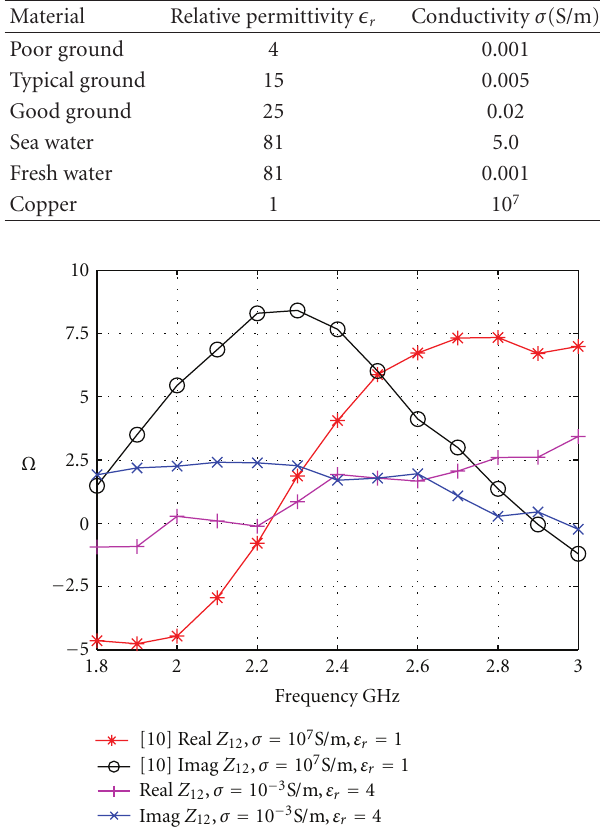
Figure 2: Mutual coupling between two λ/ 4 monopoles over poor ground and with perfect ground